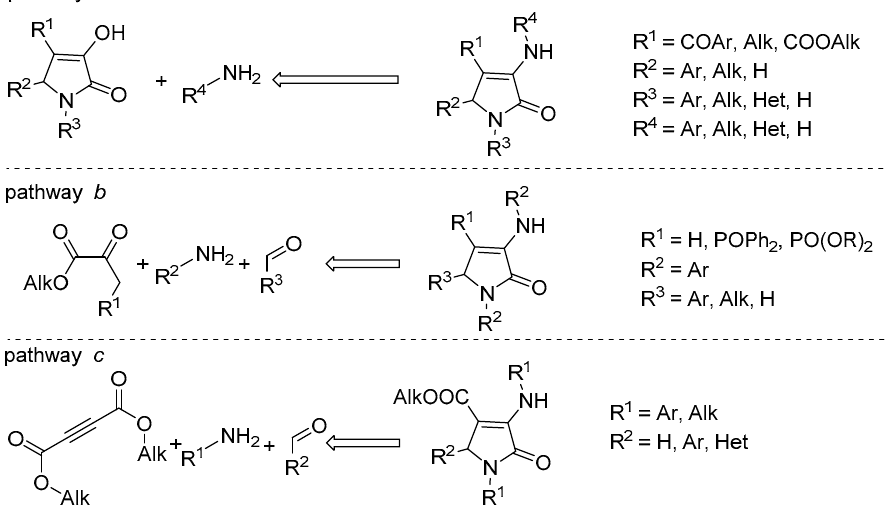
Scheme 1. Retrosynthetic pathways towards ADPs.